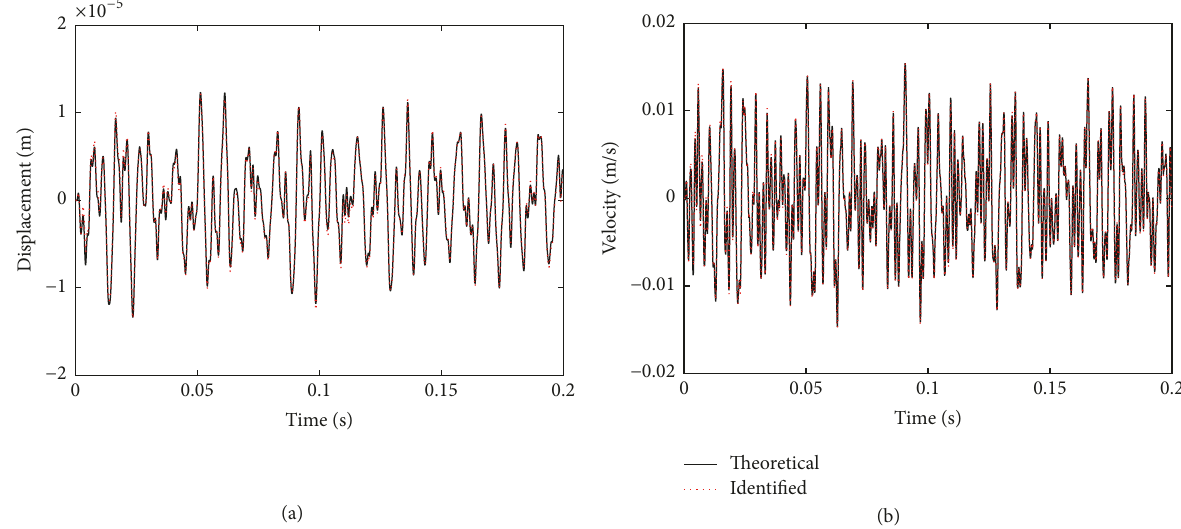
Figure 15: (a) The theoretical and identified vertical displacement at Node 70 by data fusion. (b) The theoretical and identified vertical velocity at Node 70.